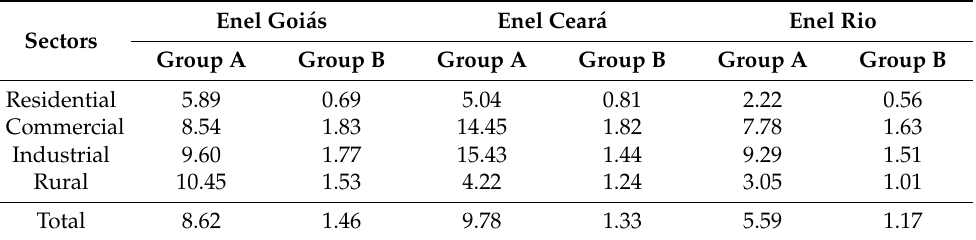
Table 1. Average consumption pattern by sector and tariff group in MWh in the 12 months prior to migrating to MMDG in the Enel group distributors.